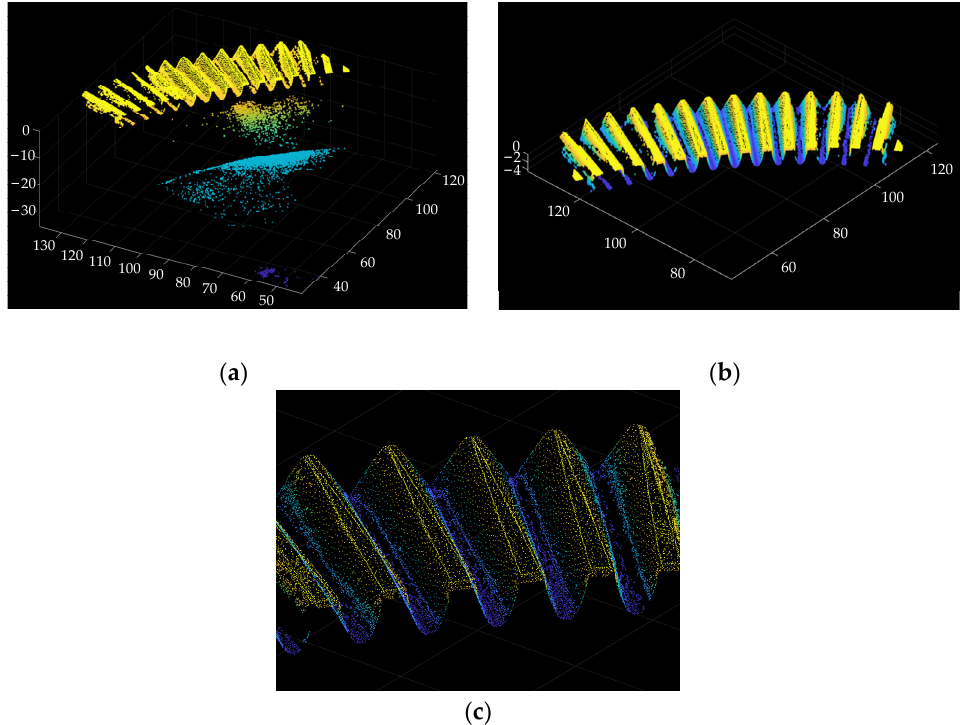
Figure 3. ( a ) Unprocessed point cloud, ( b ) filtering, and ( c ) down-sampling.